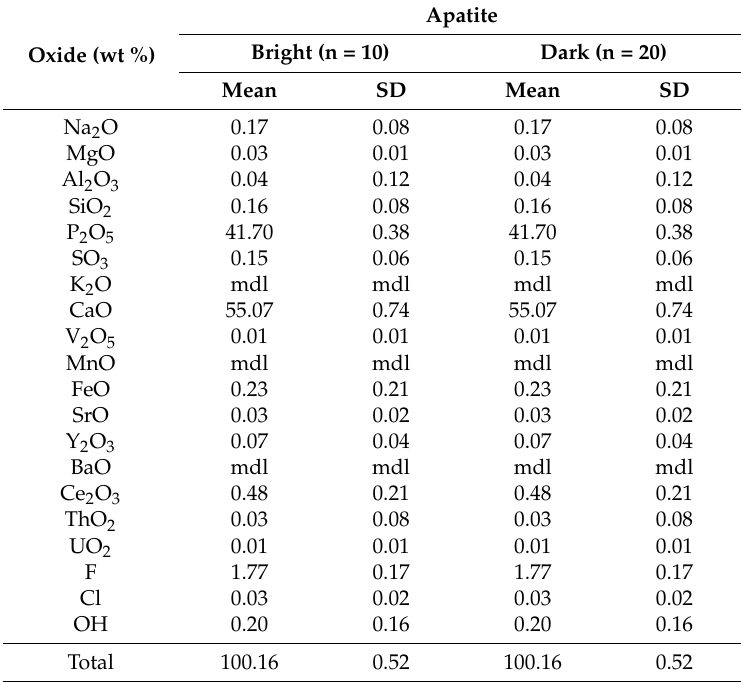
Table 4. EPMA data (wt %) for bright and dark apatites from Chadormalu MAV-inner ore apatite